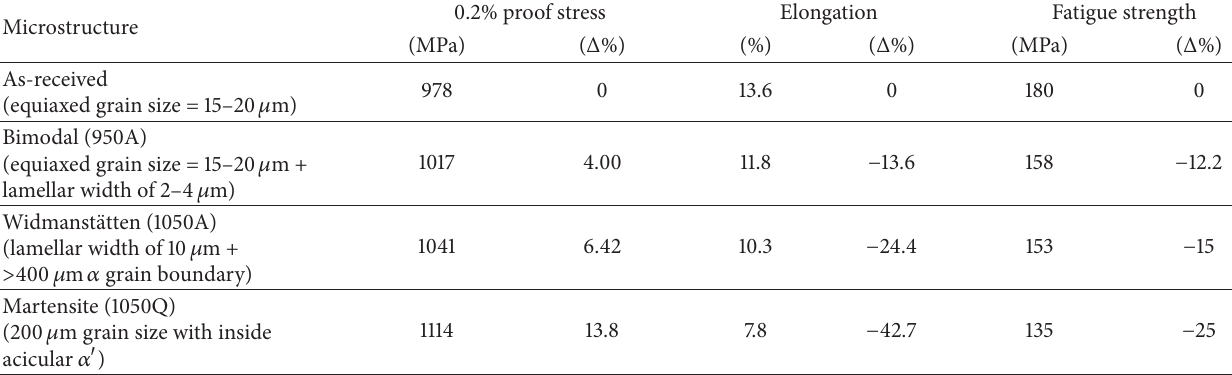
Table 2: Summary of the study showing absolute values and variance ( Δ %) of properties of AR